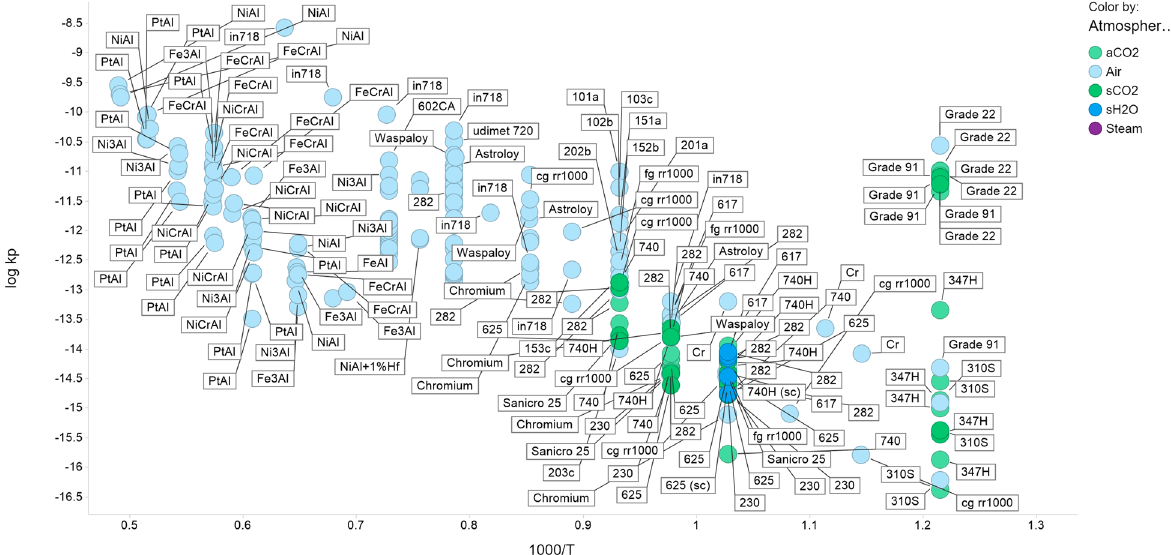
Fig. 1 Scatterplot of parabolic rate constants vs. temperature. Arrhenius plot ( x = 1000/ T , with T in Kelvin; and y = log 10 k p , with k p in units of g 2 /cm 4 /s) for the collection of alloys curated from the high-temperature oxidation literature. For alloys where no environment is explicitly reported in the paper, it is assumed the environment is air. aCO 2 is ambient pressure CO 2 , and sCO 2 is supercritical CO 2 . sH 2 O is supercritical